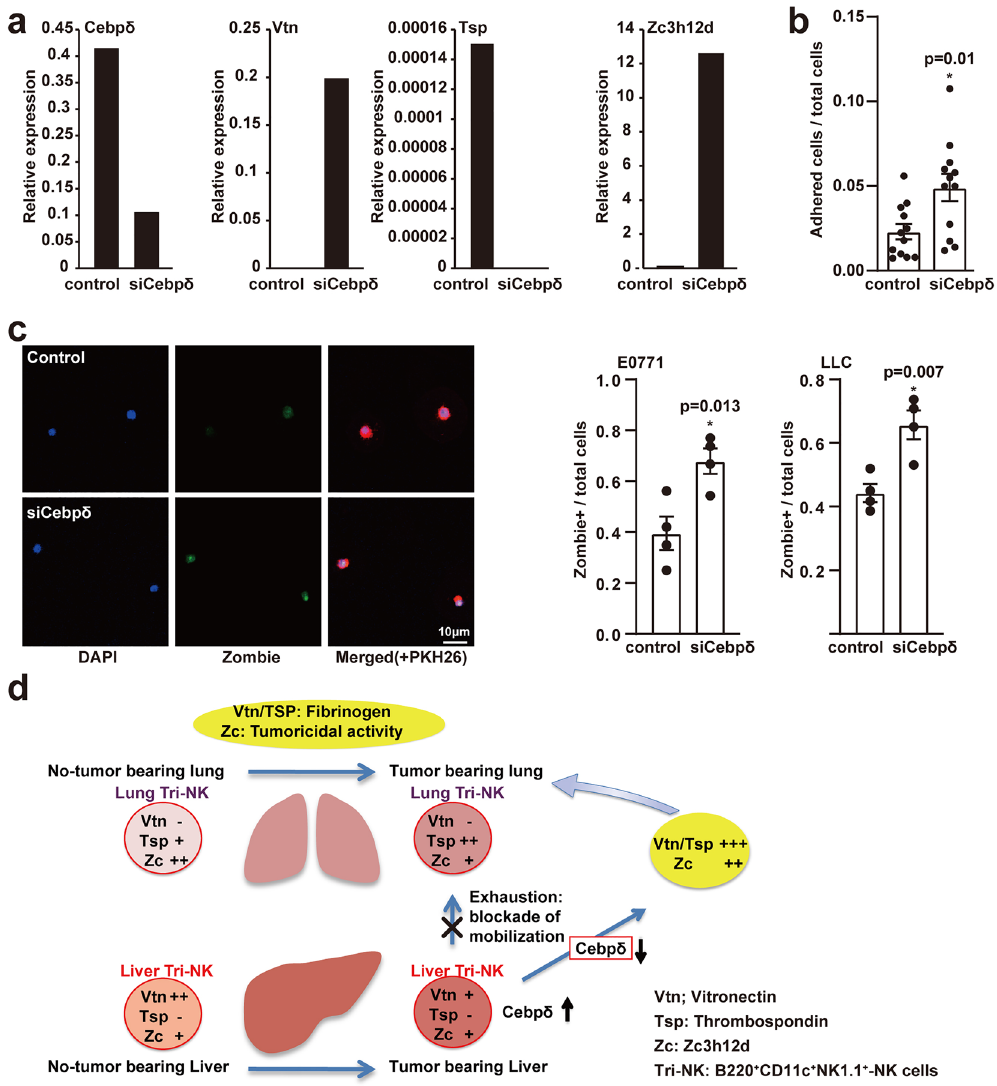
Figure 5. Restoration of exhaustion of Hepato-entrained NK cells by CEBPδ suppression. ( a ) mRNA levels of CEBPδ, Vtn, Tsp, and ZC3H12D in liver B220 + CD11c + NK1.1 + NK cells derived from tumor-bearing mouse livers 48 h after siRNA administration. Repeated data in Supplementary Fig. S8. ( b ) The ratio of attached B220 + CD11c + NK1.1 + NK cells to fibrinogen treated with control (nontarget) siRNA or CEBPδ-siRNA. ( c ) Tumoricidal assay system. Zombie green depicted representative dead tumor cells. Scale bar, 10 μm. The ratio of killed PKH-labeled tumor cells cocultured with control (nontarget) siRNA- or CEBPδ-siRNA-treated B220 + CD11c + NK1.1 + NK cells of tumor-bearing mouse liver. N = 4. Error bars denote the mean ± SEM, and P values (significant) are shown in graphs ( b , c ). ( d ) Summary of Vtn, Tsp, and ZC3H12D expression in liver B220 + CD11c + NK1.1 + NK cells in the pre-metastatic liver and lungs. A reduction of Vtn in the liver was seen during primary tumor progression. Intense Vtn and/or Tsp upregulation by inhibiting CEBPδ increases homing of liver B220 + CD11c + NK1.1 + NK cells, accompanying ZC3H12D activation in killing metastatic tumor cells in the